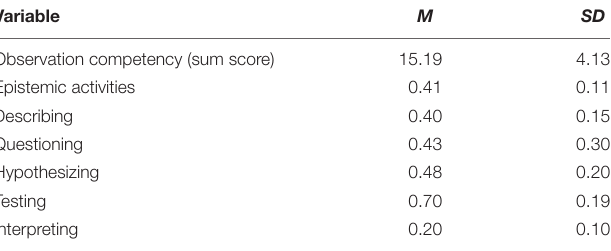
TABLE 5 | Descriptive for overall observation competency, subscales, and facets.